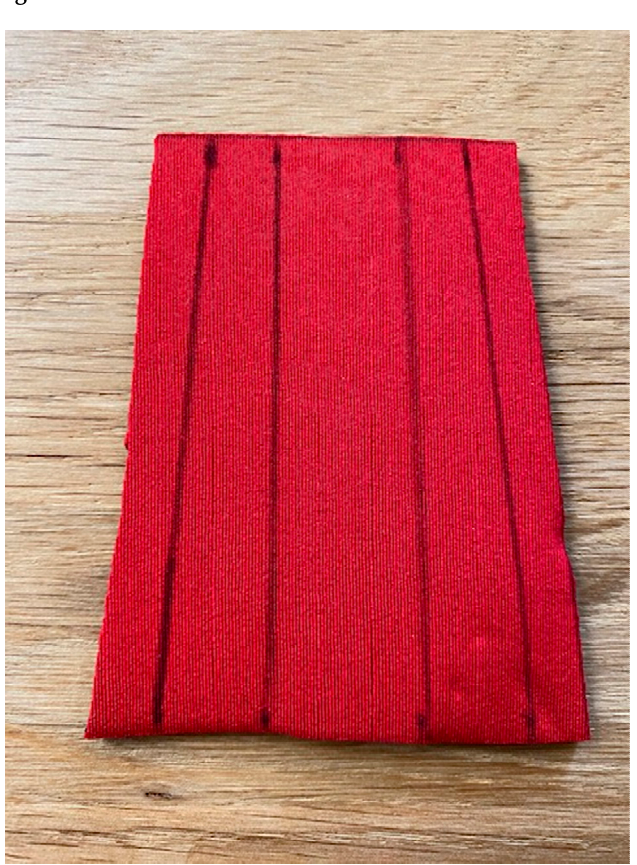
Figure 7. ETDNO pa tt ern lines. Figure 7. ETDNO pattern